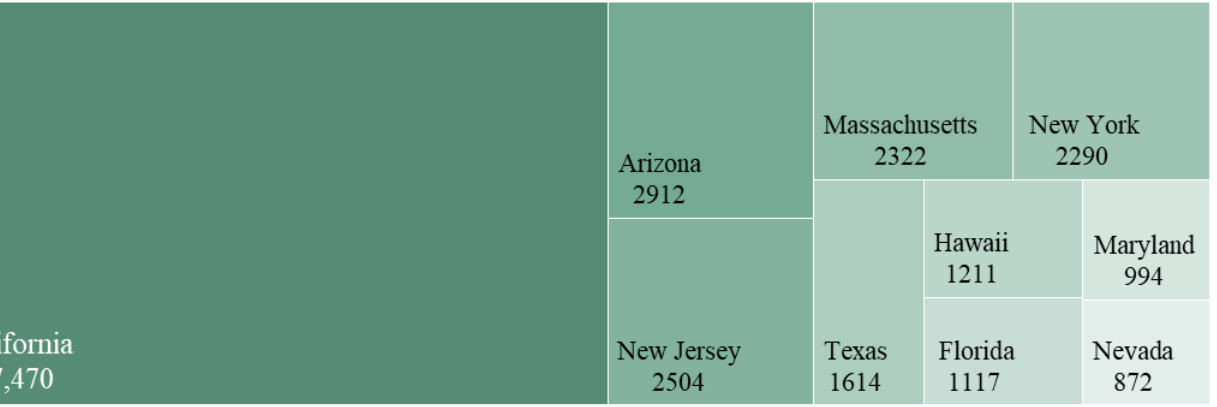
Figure 4. Building distributed solar photovoltaic generation by state in 2020 (in 10 6 kilowatt-hours, adopted from [50]).